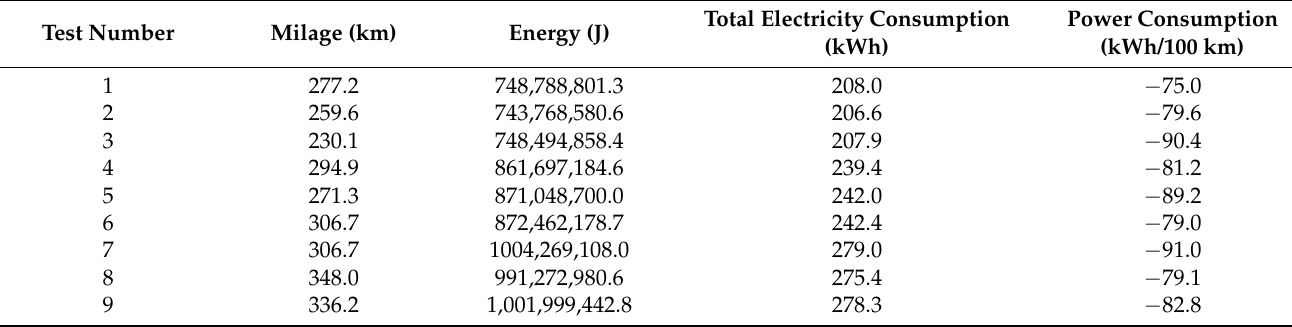
Figure 19. Partial screenshot of test parameters. Table 10. Summary of energy